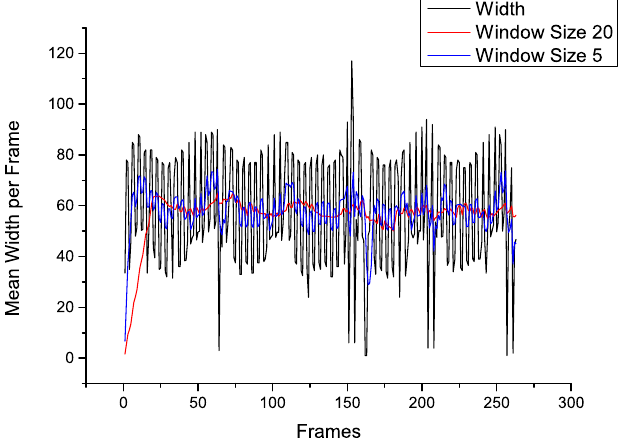
Figure 15. BFSOOK max widths per Frame and Thresholding Window.